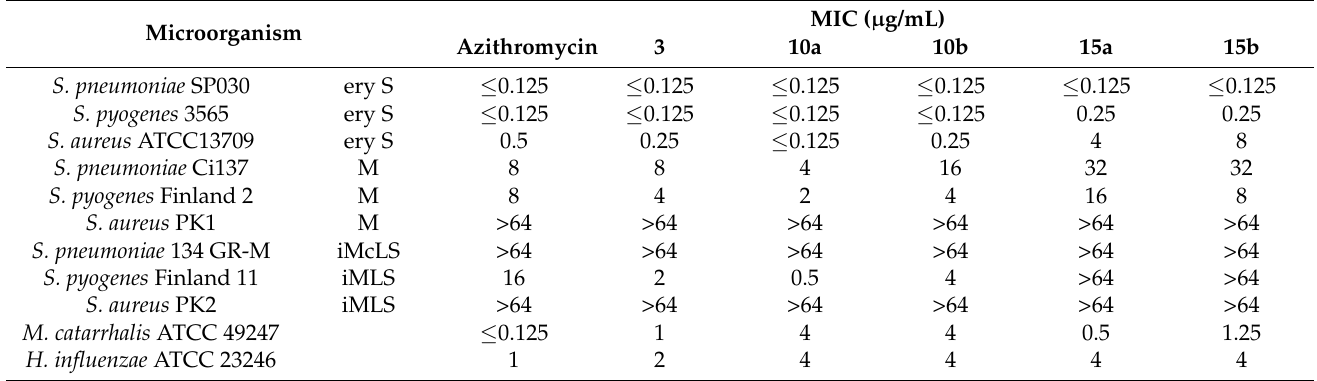
Table 1. Antibacterial activities of synthesized macrolides. Bacteria tested are standard strains available from ATCC collection, as well as clinical isolates that are either sensitive to macrolide antibiotics, or have well-characterized macrolide resistance